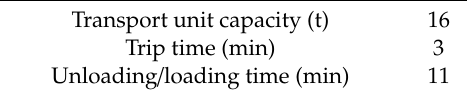
Table 3. Data on the transport between